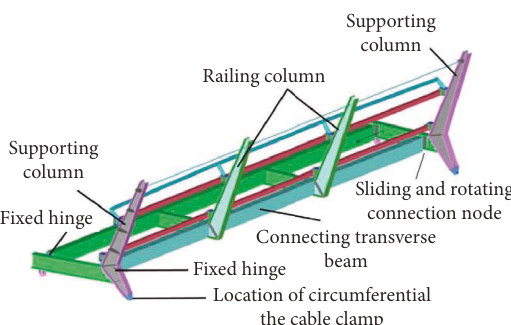
Figure 15: Structure composition of the circular catwalk.